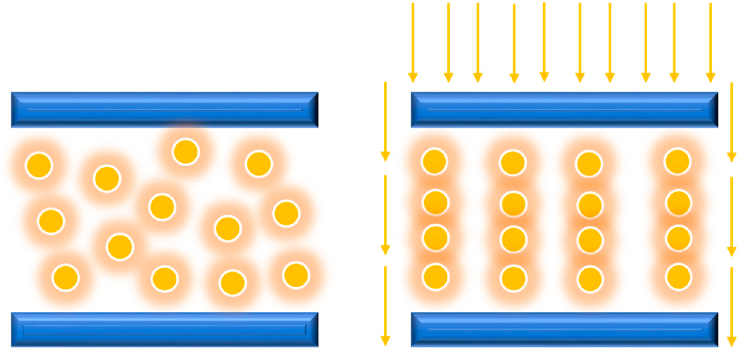
Figure 5. The mechanism of magnetorheological (MR) fluid [68].